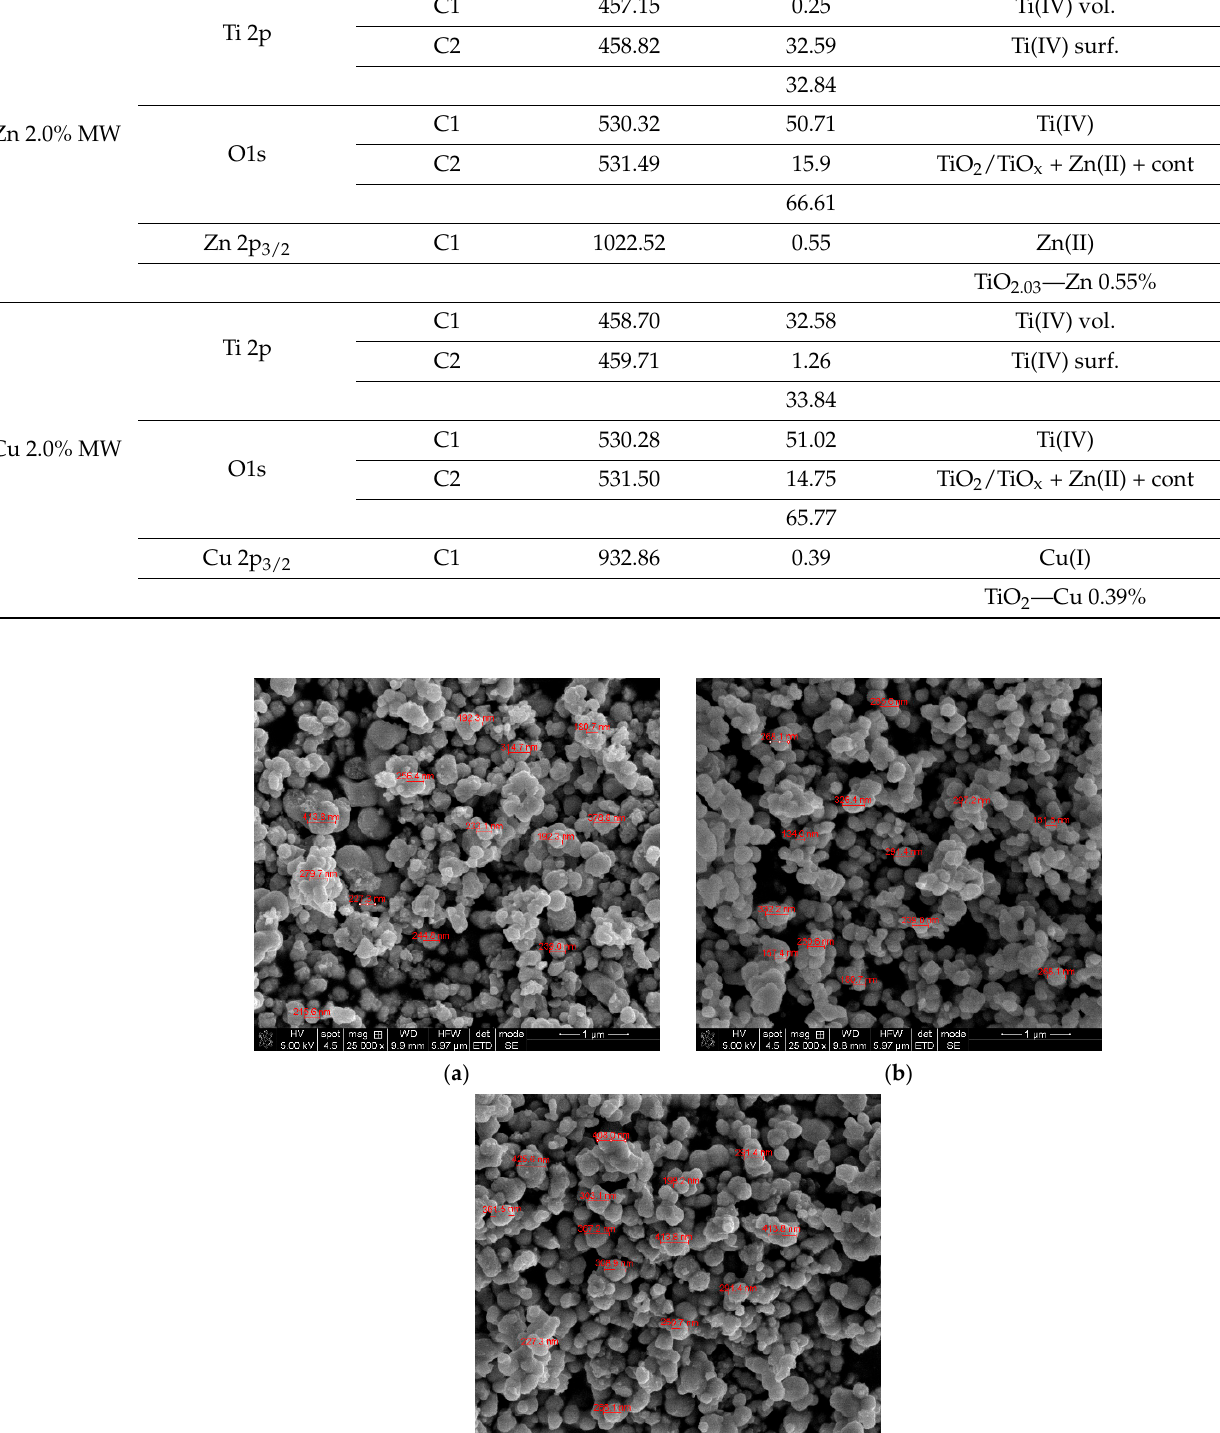
% at Interpretation